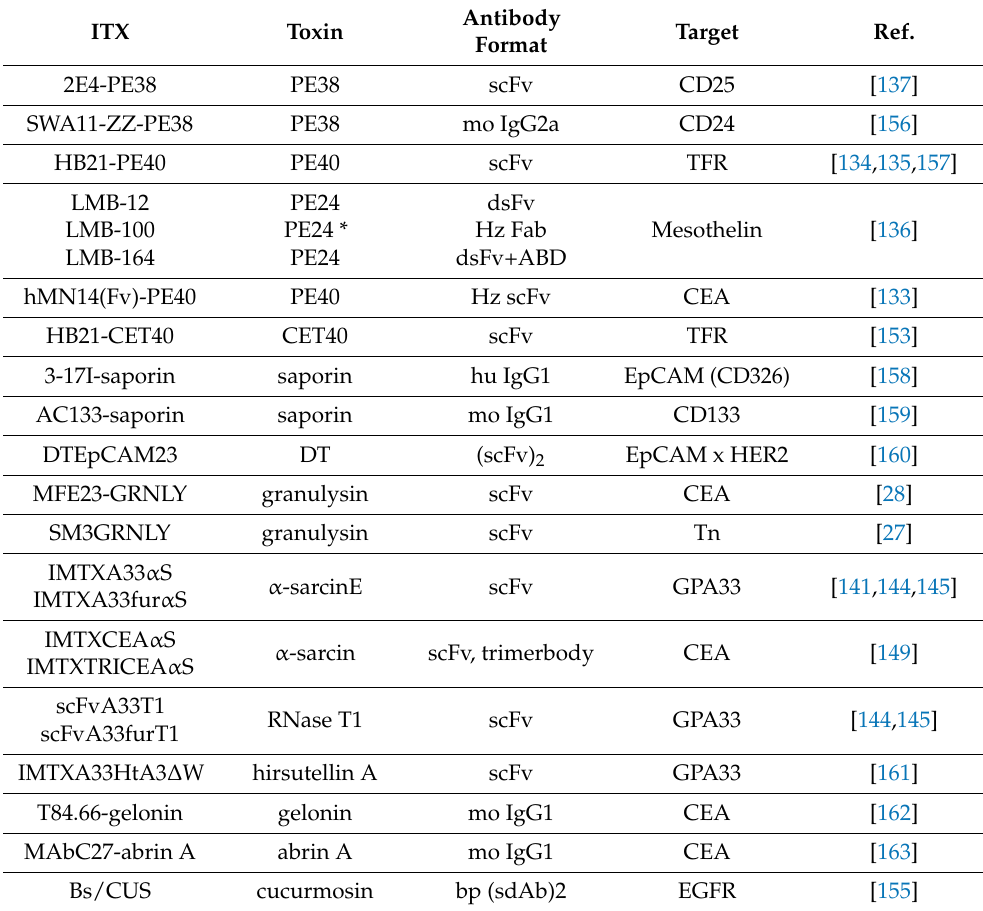
Table 2. Immunotoxins in preclinical development for CRC